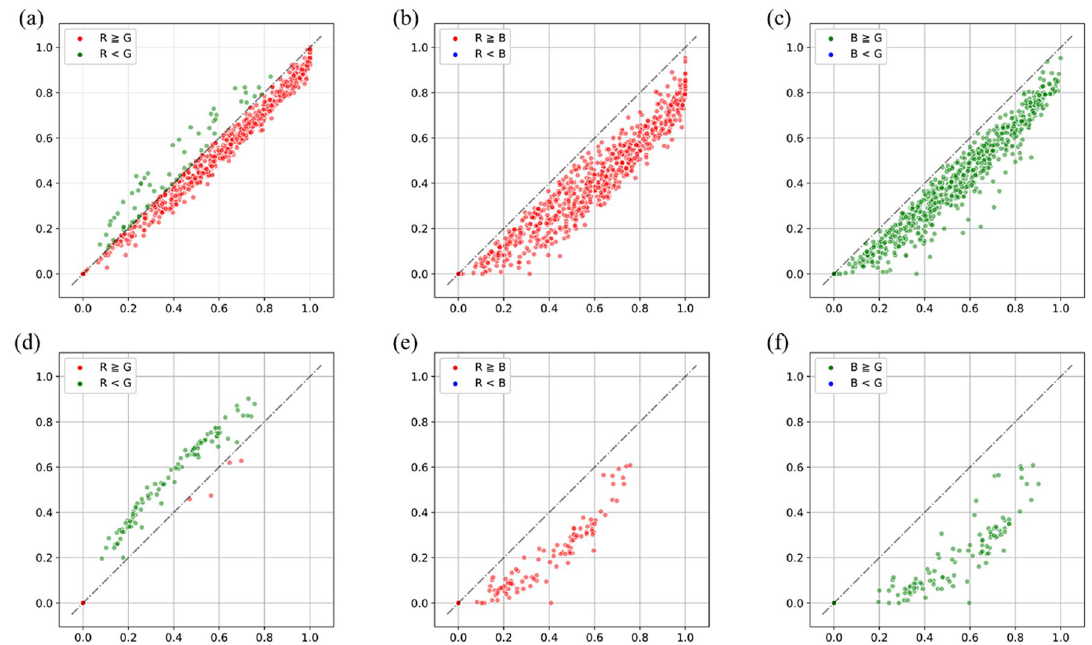
Figure 4. Distribution between channels of pixels in crop images. ( a) , ( b) and ( c ) show the object; ( d) , ( e) and ( f ) show the